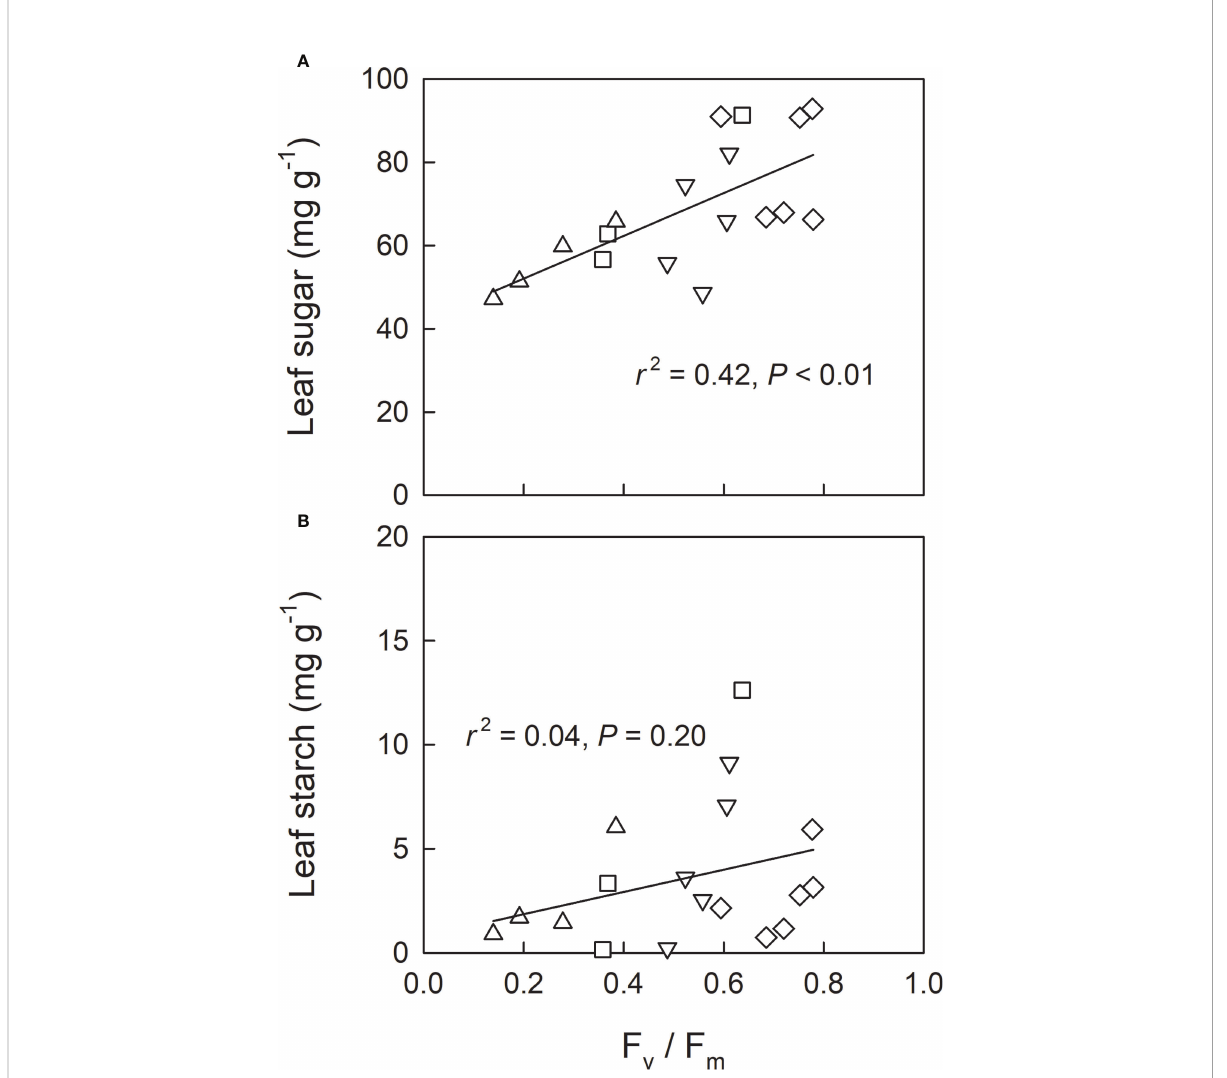
FIGURE 5 Relationship between F v /F m and leaf soluble sugar content (A) and leaf starch content (B) in leaves (measured and sampled on 19 th Oct) offullmoon maple seedlings grown under shade (L0, diamond), transferred from shade to open conditions on 5 th Oct (LH1, square), on 12 th Oct (LH2, triangle-up), and on 18 th Oct (LH3, triangle-down). Linear regression analysis was conducted for the pooled data across the light